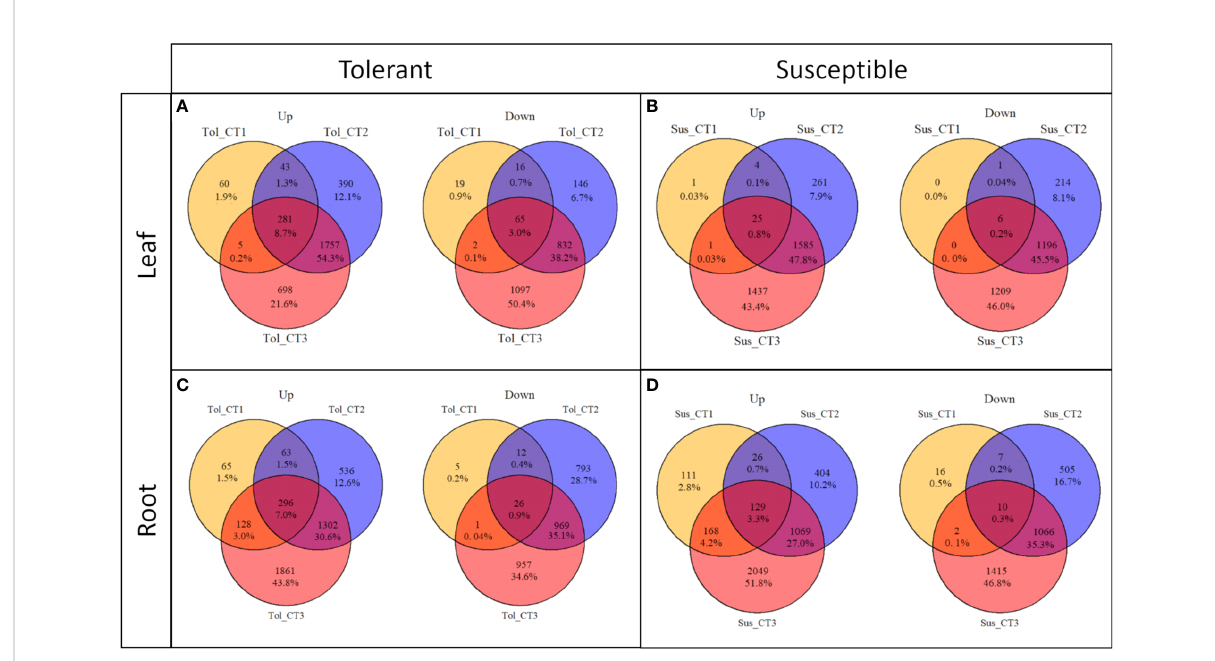
FIGURE 2 Commonalities and differences in DEGs across drought treatment time points in two potato varieties. Up and down-regulated DEGs in leaf (A, B) and root (C, D) in tolerant (Tol) and susceptible (Sus) varieties in three drought-stressed time points (early T1, late T2 and recovery after rewatering T3) compared with the non-stressed control